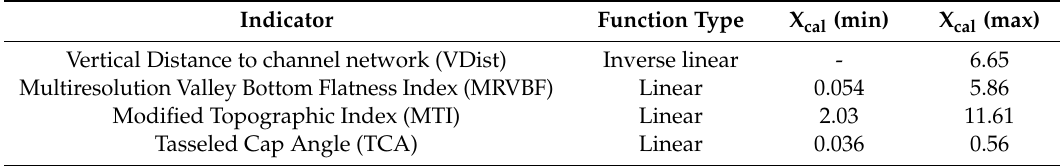
Table 1. Calibration values for the fuzzy membership functions obtained for the Naryn River.